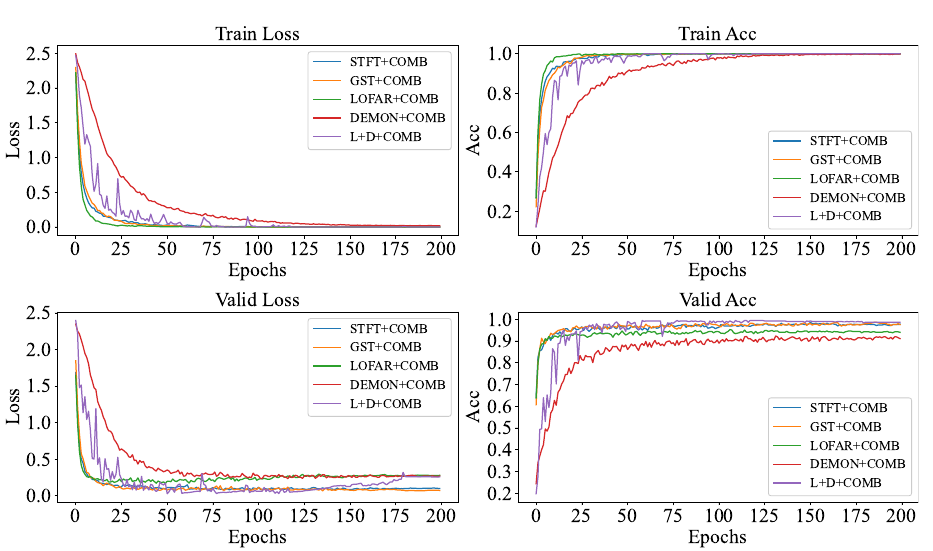
Figure 11. Training process with different features, L+D+COMB is an abbreviation for LOFAR+ DEMON+COMB. The upper panel shows the loss and accuracy on the training dataset while the lower panel for validation